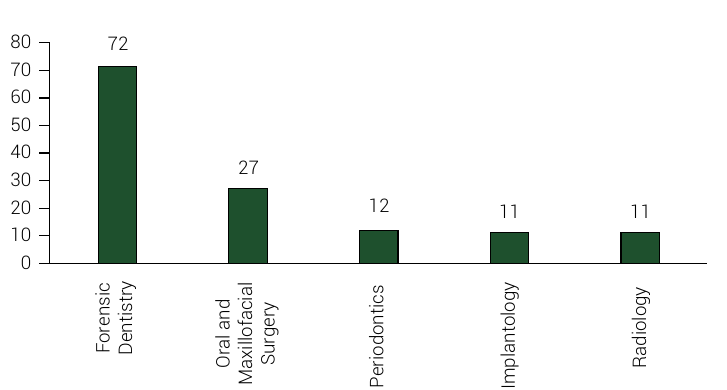
Regarding the data collected on expert witnesses, in 12% (n=29) of the lawsuits, no expert witness was appointed. In 65% (n=161) of the lawsuits, an expert witness was appointed. In the remaining 23% of lawsuits, it was not possible to determine expert witness appointment, as cases had not reached this legal phase at time of the data collection. In the lawsuits where an expert witness was appointed, 71% (n=115) were specialized dentists, of which 61% (n=70) had one specialty, 37% (n=43) had two spe- cialties, and 2% (n=2) of the expert examinations were performed by medical doc- tors. In addition, among the appointed expert witness, 63% (n=72) were registered as Forensic Dentistry specialists (Figure 4).